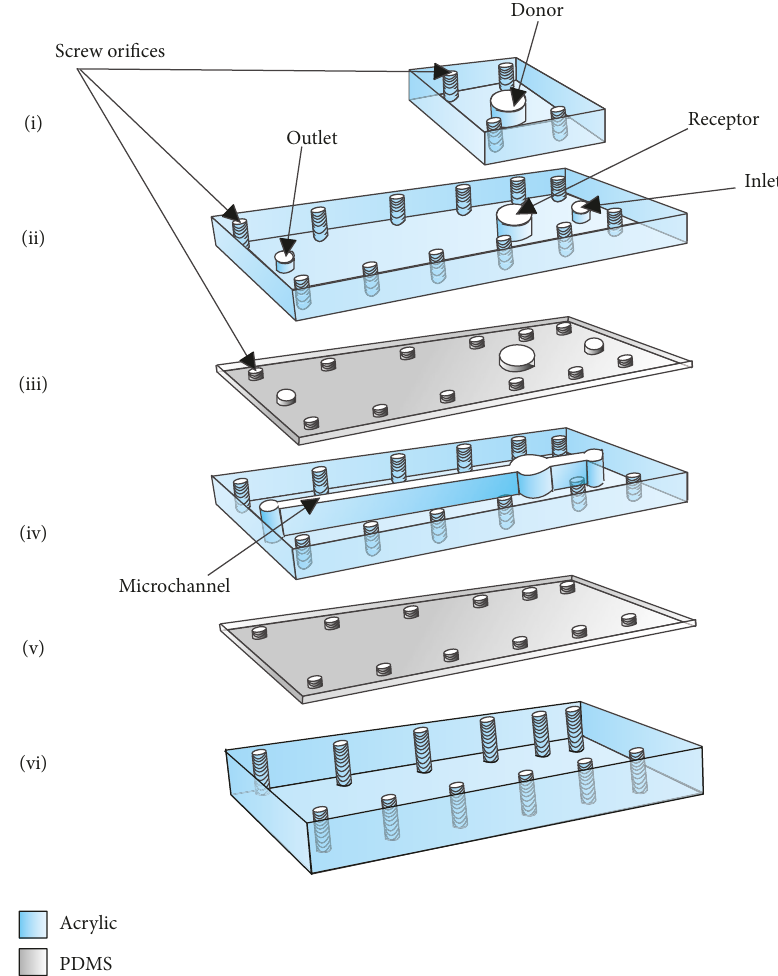
Figure 1: Expanded view of the diffusion microchip device. The top layer has a sample donor and the second layer contains the receptor and inlet/outlet. The main channel layer provides circulating flow that transports targets for